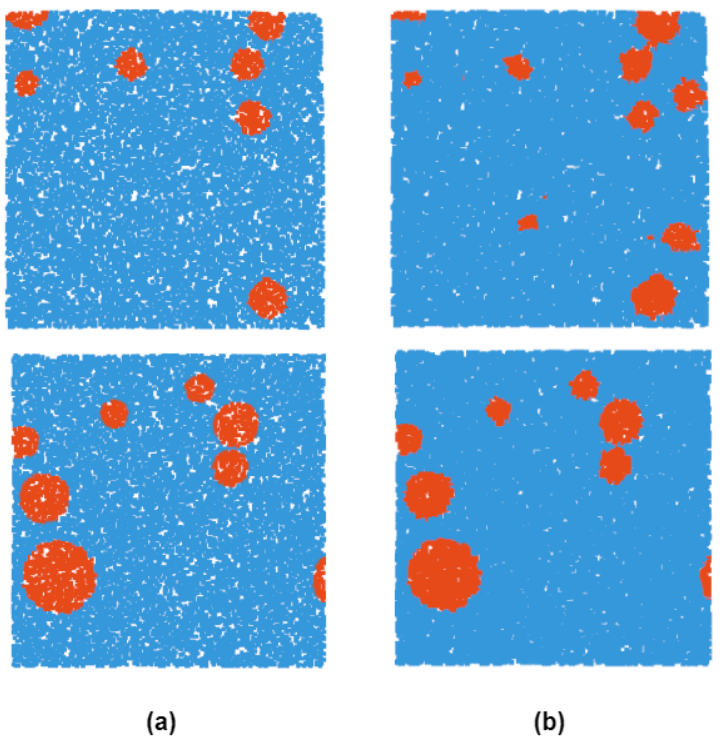
Figure 4. Illustration of the pre-detection results. ( a ) shows the ground truth in the dataset. ( b ) repre- sents the preliminary detection result after the point cloud semantic